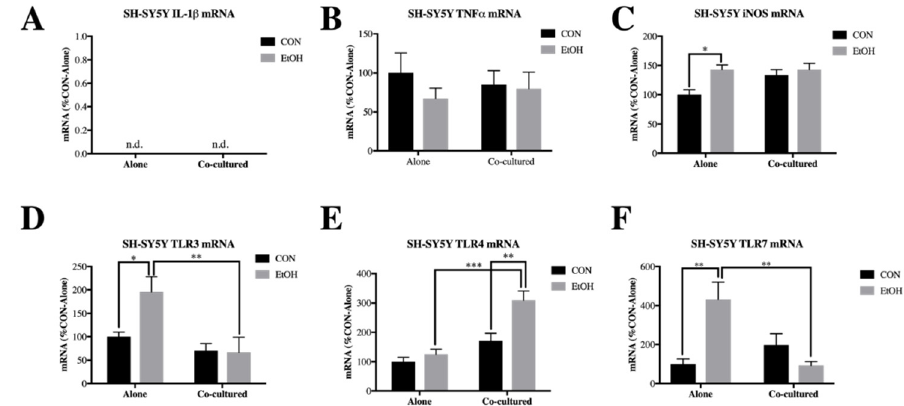
Figure 3. Co-culture alters ethanol-induced TLRs in SH-SY5Y. SH-SY5Y were treated with ethanol (EtOH, 100 mM) for 24 h alone or while co-cultured with BV2 microglia. Cell lysates were examined for mRNA expression. ( A ) IL-1 β mRNA was not detected in SH-SY5Y cell lysates. ( B ) TNF α expression was not significantly a ff ected by EtOH or co-culture in SH-SY5Y. ( C ) iNOS expression was significantly increased by EtOH in SH-SY5Y alone (143 ± 8.0%). ( D ) TLR3 expression was significantly increased by EtOH in SH-SY5Y alone (196 ± 32%) but not in co-cultured SH-SY5Y. ( E ) TLR4 expression was significantly increased by EtOH in co-cultured SH-SY5Y (310 ± 31%). ( F ) TLR7 was significantly increased by EtOH in SH-SY5Y alone (431 ± 89%) but not in co-cultured SH-SY5Y. Data is represented as %CON (control)-Alone ± SEM, n = 5–6 wells per group. n.d. = not detected ( > 40 cycles) * p <